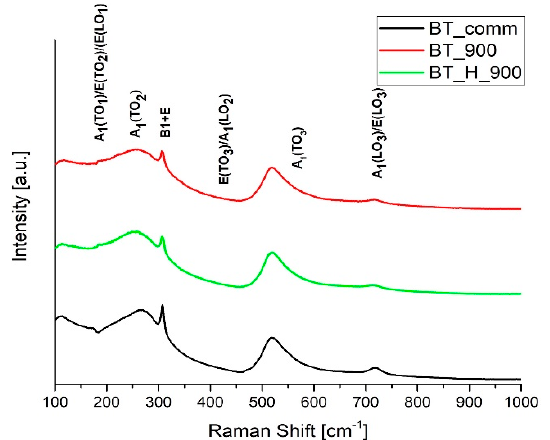
Figure 9. Raman spectra of BaTiO 3 samples: BT_comm (black line), BT_900 (red line), and BT_H_900 (green line).